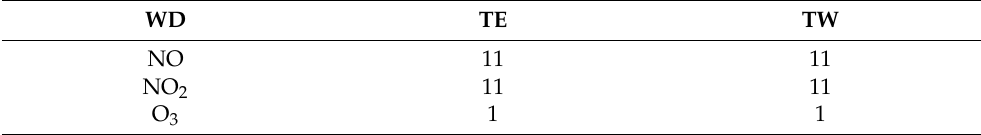
Table 4. Ranking of 2020 with the period of 2010–2020 with 1 for the highest value and 11 for the lowest value for the two Toronto stations, Toronto East (TE) and Toronto West (TW) for weekdays. WD TE TW NO NO 2